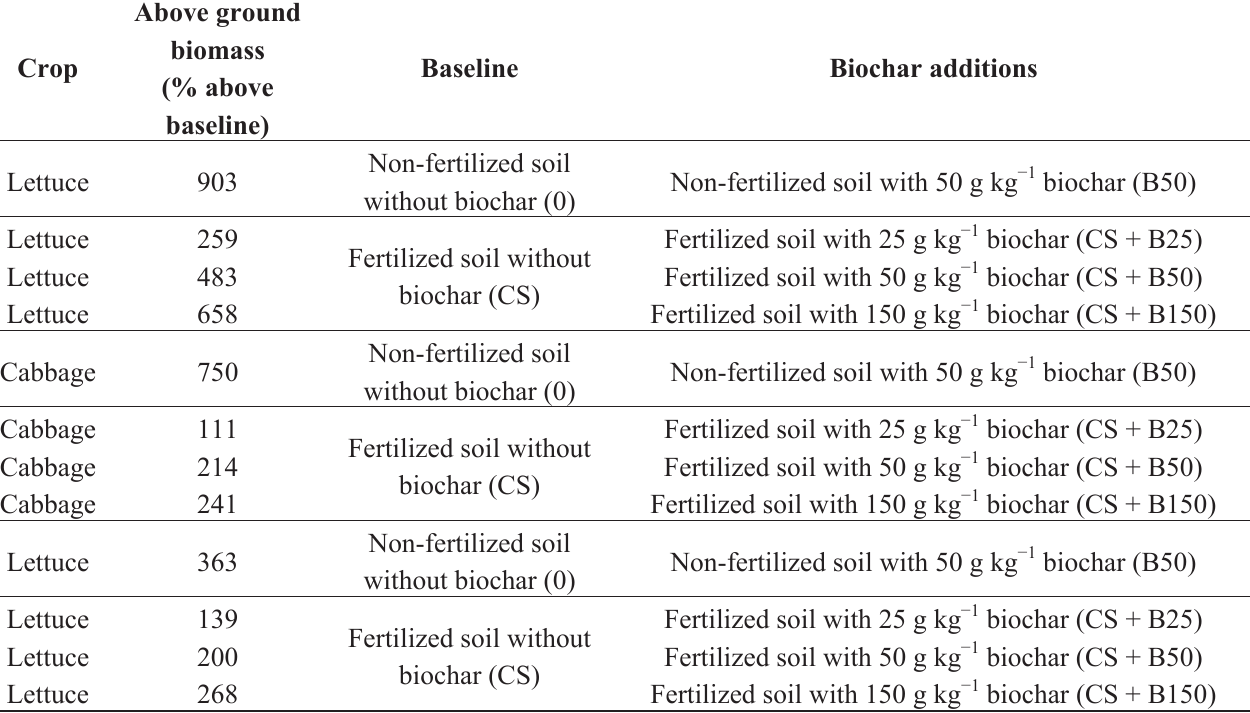
Table 3. Percentage increase in crop yields (above ground biomass) from biochar addition in all treatments from a baseline scenario of non-fertilized soil (0) and soil fertilized with compost, liquid compost and lake sediment (CS). Note: for treatment “0” in cabbage, n =